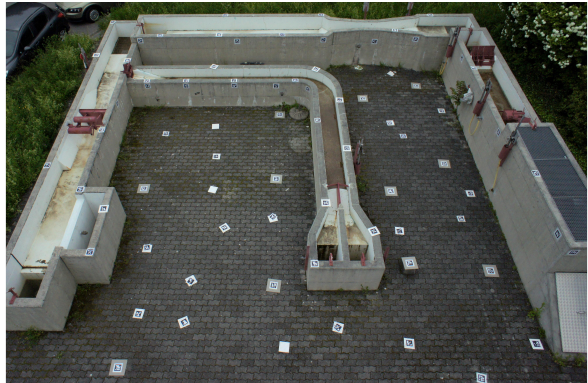
Table 4. Measured vs. estimated Lever Arm